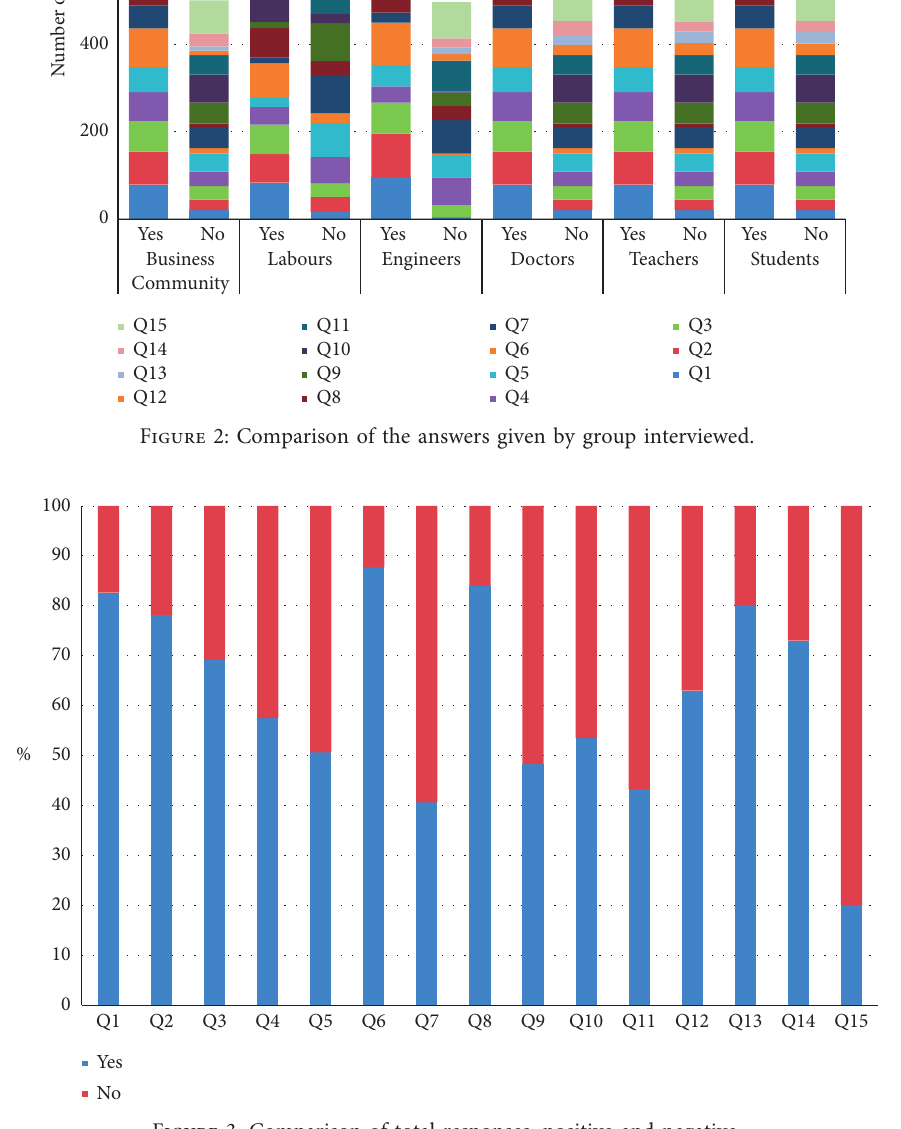
Figure 3: Comparison of total responses: positive and